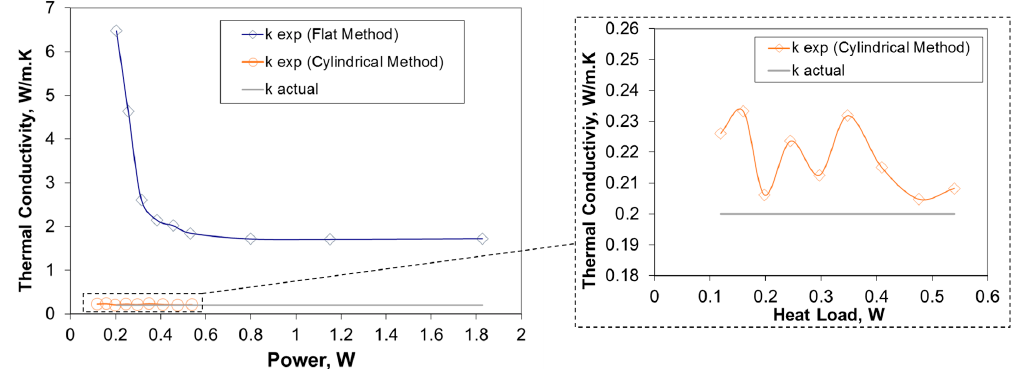
Figure 12. Comparison between the actual and resulted thermal conductivities obtained by flat and cylindrical configuration methods.